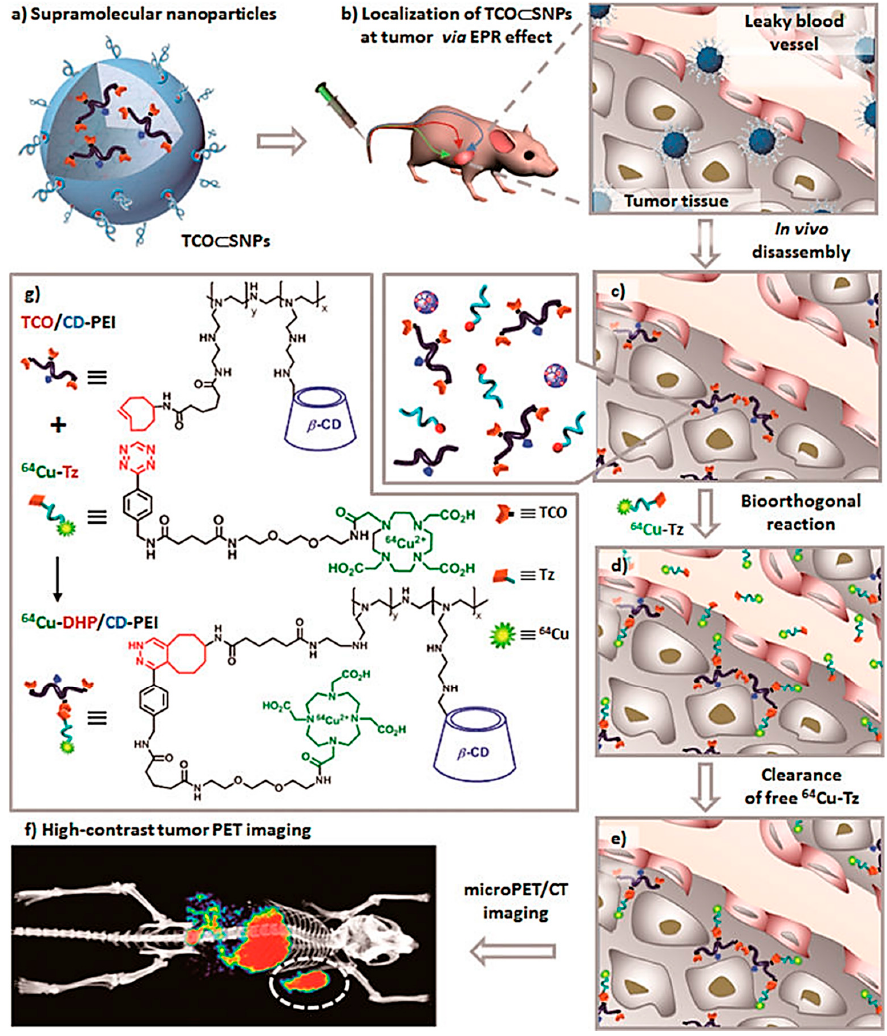
Figure 7. Schematic representation of a new approach for pretargeted PET imaging that leverages the utilities of supramolecular nanoparticles (SNPs) and bioorthogonal chemistry: ( a ) Supramolecular synthetic strategy is employed for preparing the tumor-targeting agent (TCO ⊂ SNPs); ( b ) after intravenous injection, the tumor EPR effect drives preferential accumulation of TCO ⊂ SNPs in tumor; ( c ) after TCO ⊂ SNPs have accumulated in tumor, TCO ⊂ SNPs disassemble to release a TCO-grafted molecular building block, TCO/CD-PEI; ( d ) a radiolabeled reporter ( 64 Cu-Tz) is then injected for bioorthogonal reaction with tumor-retained TCO/CD-PEI; ( e ) the unreacted 64 Cu-Tz was cleared quickly from the body; ( f ) the resulting dihydropyrazine (DHP) conjugation adduct ( 64 Cu-DHP/CD-PEI) confines radioactivity in tumor, resulting in high-contrast tumor PET imaging. ( g ) Chemical structures of the bioorthogonal reactions between TCO/CD-PEI and 64 Cu-Tz (adapted from [101], ACS Nano, 2016).